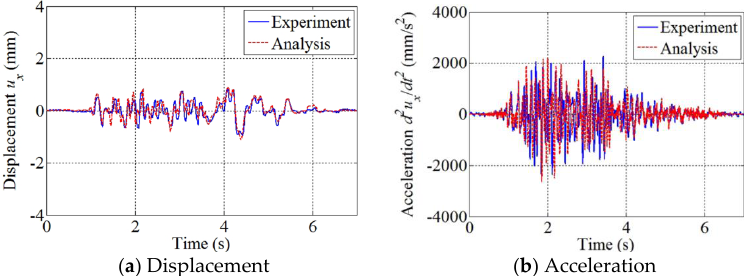
Figure 21. Third-floor response in the x direction due to the low-intensity ground motion; responses sampled at point A.